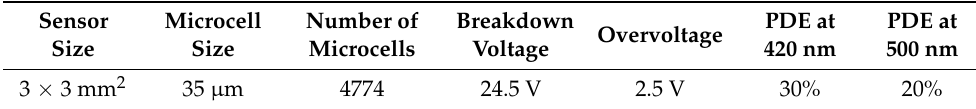
Table 2. Main characteristics of the MicroFC-30035-SMT SiPM.